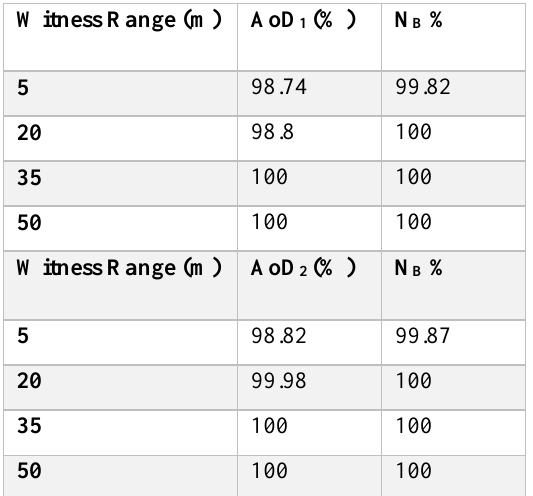
Table 2. Accuracy of detection, AoD, at different witness ranges with case 1: TR is 50 m E is 0 to 4, Pr is 0 to 6, Sc is 40 and case-2: TR is 100 m, E is 0:5, Pr is 0 to 8, Sc is